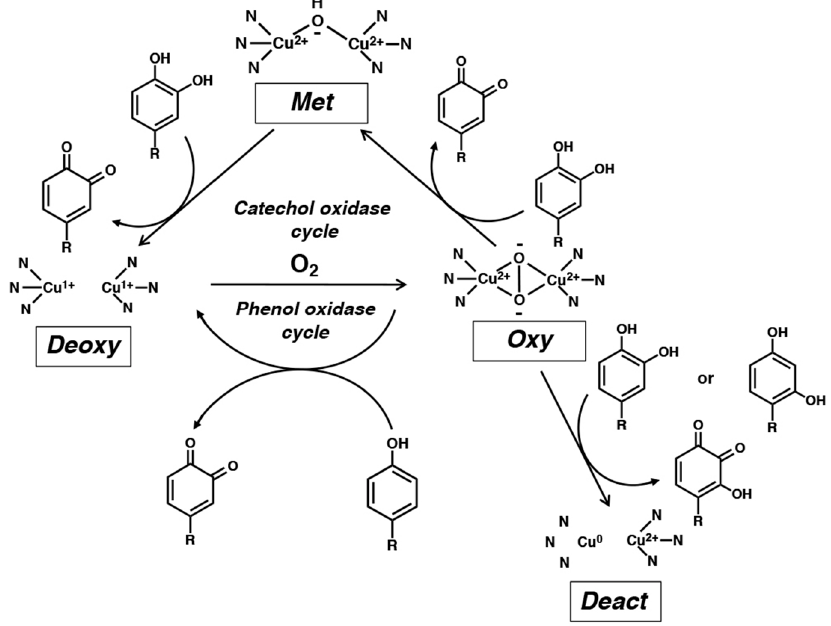
Figure 2. Relationship among the four oxidative states of tyrosinase [7].